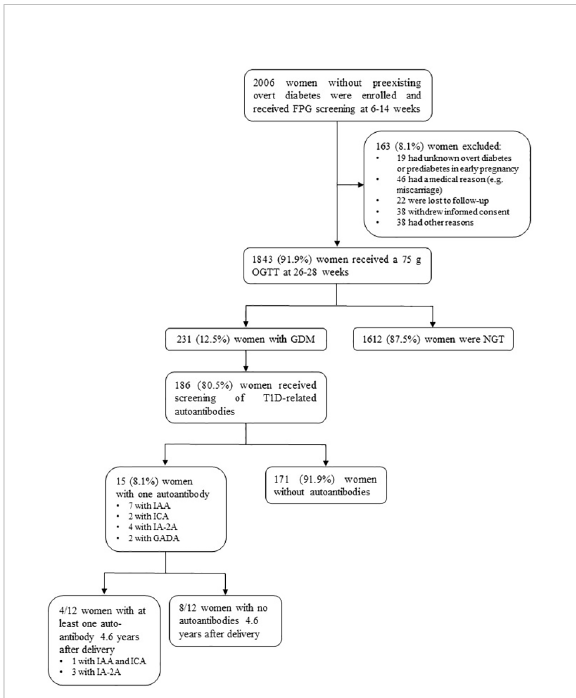
FIGURE 1 Flow diagram of the BEDIP-N study cohort. FPG, fasting plasma glucose; OGTT, oral glucose tolerance test; GDM, gestational diabetes mellitus; NGT, normal glucose tolerant; T1D, type 1 diabetes mellitus; IAA, insulin autoantibodies; ICA, islet cell antibodies; IA-2A, insulinoma-associated protein-2 antibodies; GADA, glutamic acid decarboxylase